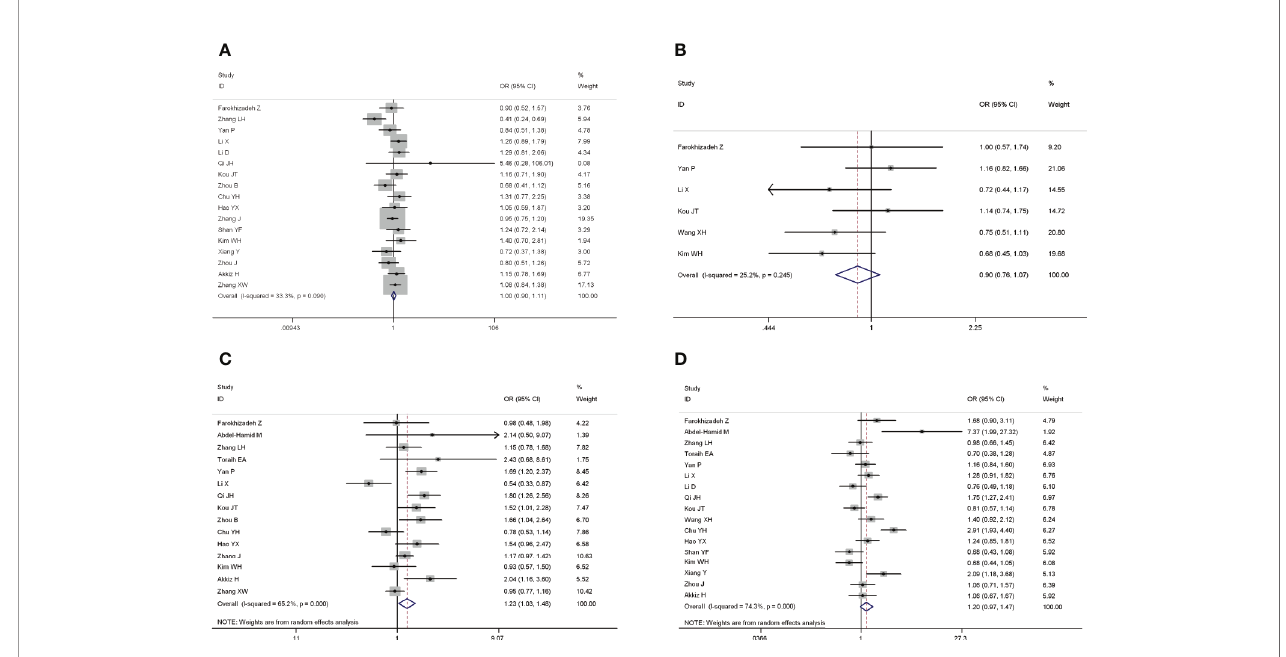
FIGURE 3 | Forest plots of the association of four single nucleotide polymorphisms (SNPs) and hepatocellular carcinoma (HCC) risk. (A) miR-146a rs2910164; (B) miR-149 rs2292832; (C) miR-196a2 rs11614913; (D) miR-499